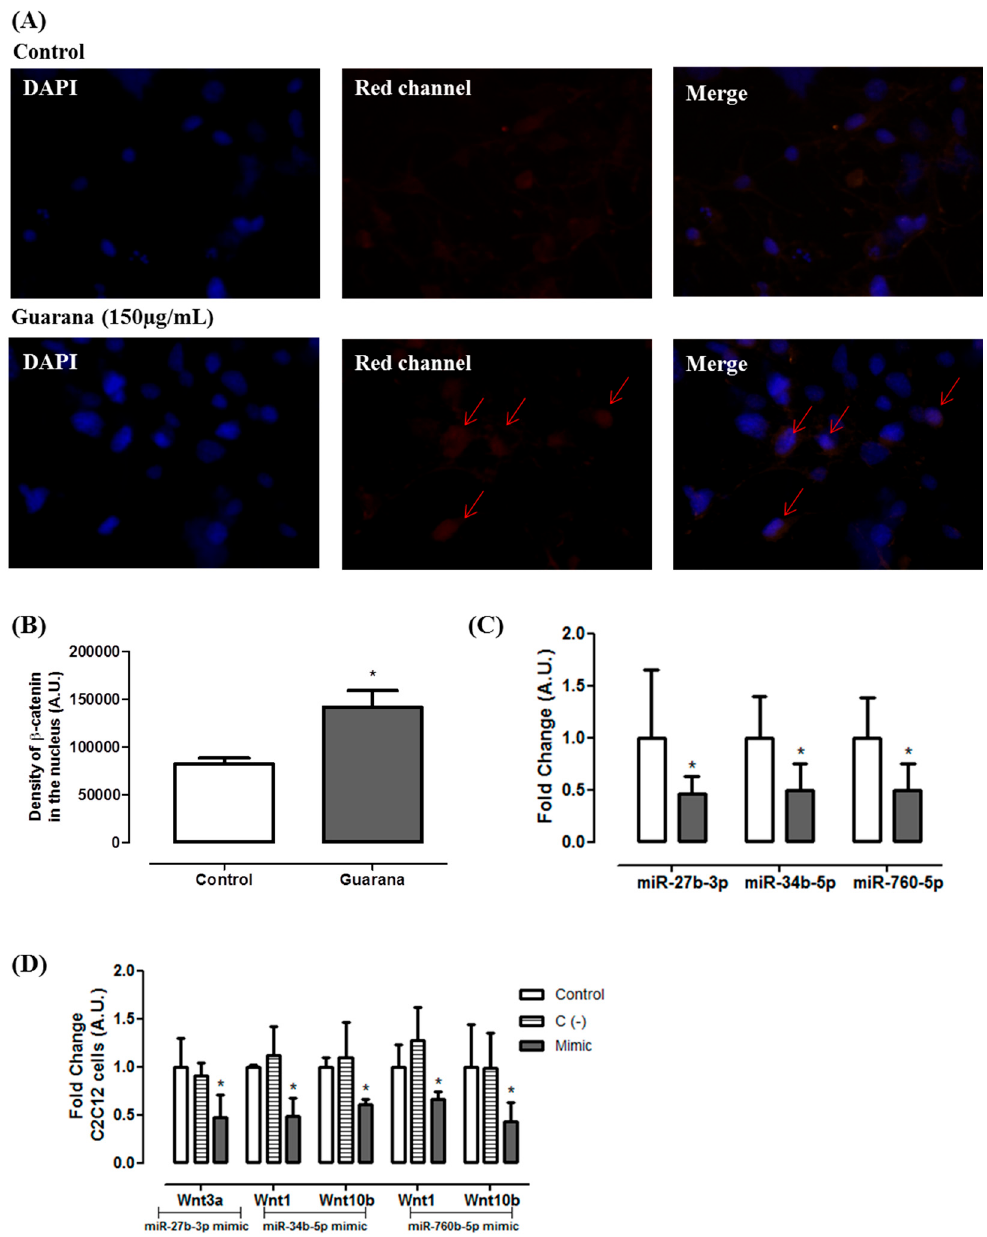
Figure 3. ( A ) Immunofluorescence of β -catenin after 96 h of incubation with differentiation medium (Control group) and differentiation medium + guarana150 µ g/mL (Guarana group) in 3T3L1 cells; ( B ) Density of β -catenin in the nucleus after 96 h of incubation with differentiation medium (Control group—white bar) and differentiation medium + guarana 150 µ g/mL in 3T3L1 cells. Density was evaluated using Image J software. ** Guarana group (grey bar) p < 0.001 compared to Control group (white bar); ( C ) miRNA expression of mmu-miR-27b-3p, mmu-miR-34b-5p and mmu-miR760-5p after 96 h of guarana treatment (150 µ g/mL) in 3T3L1 cells. White bars correspond to Control group and grey bars correspond to Guarana group. Error bars reflect SEM. * Significative down-regulation was considered when the fold change was ≤− 0.5 and significative up-regulation was considered when the fold change was ≥ +2; ( D ) Gene expression of Wnt1 , Wnt3a and Wnt10b in C2C12 cells transfected with mmu-miR-27b-3p, mmu-miR-34b-5p or mmu-miR760-5p mimics. White bars corresponding to Control, striped bars corresponding to C ( − ) = negative control and grey bars corresponding to mmu-miR-27b-3p, mmu-miR-34b-5p or mmu-miR760-5p mimics.